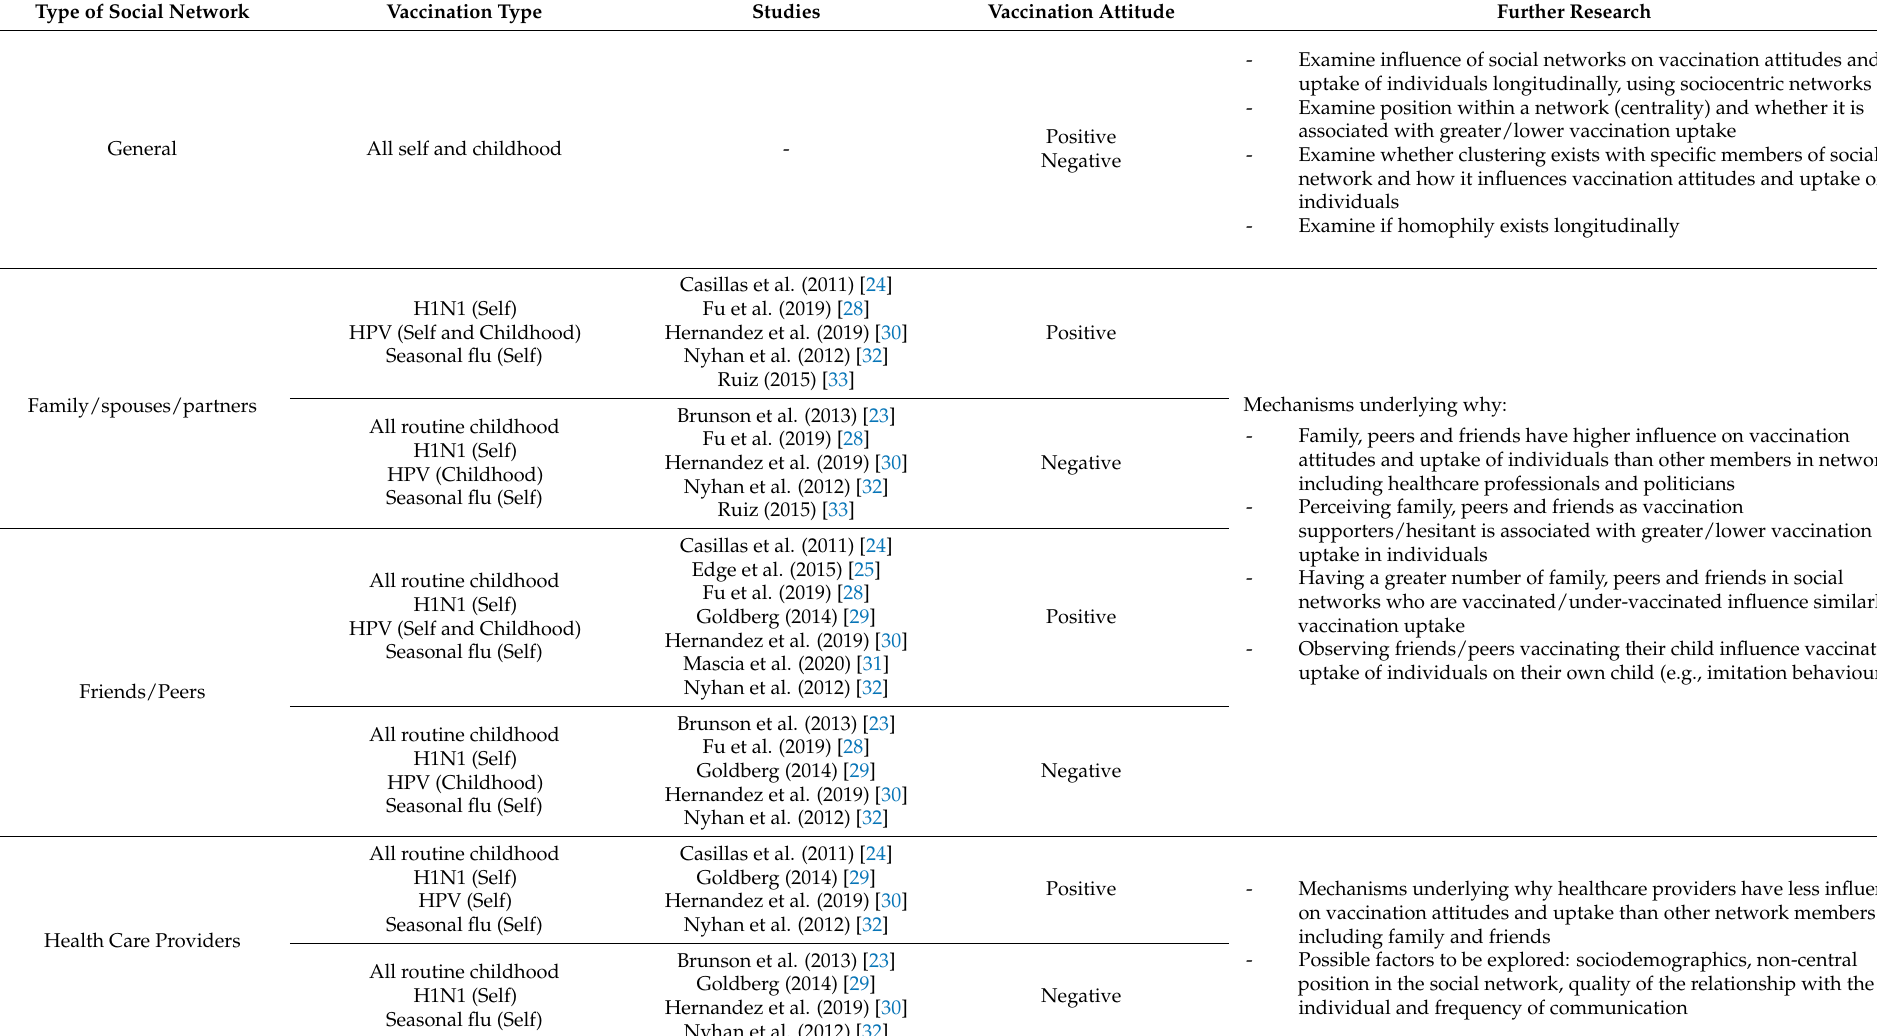
Table 3. Needs for further research based on types of social network, vaccinations and